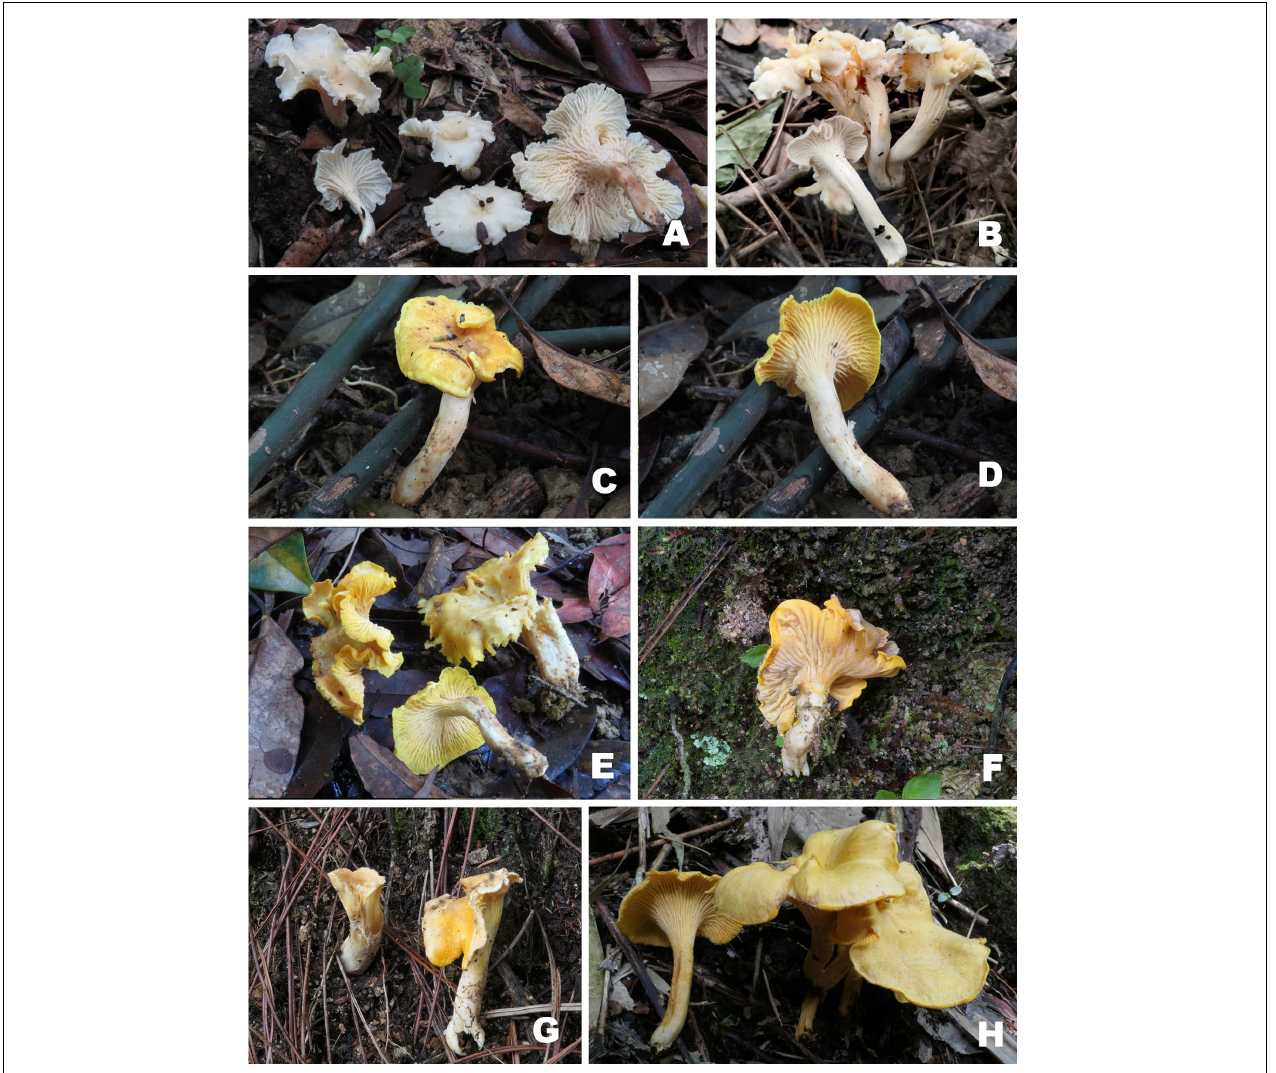
FIGURE 3 | Basidiomata of Cantharellus subg. Cantharellus species. (A,B) Cantharellus albopileatus (A) FHMU1987, holotype; (B) FHMU6850; (C–E) Cantharellus chuiweifanii (C,D) FHMU5335; (E) FHMU2839; (F,G) Cantharellus pinetorus (F) FHMU3759, holotype; (G) FHMU3749; (H) Cantharellus ravus